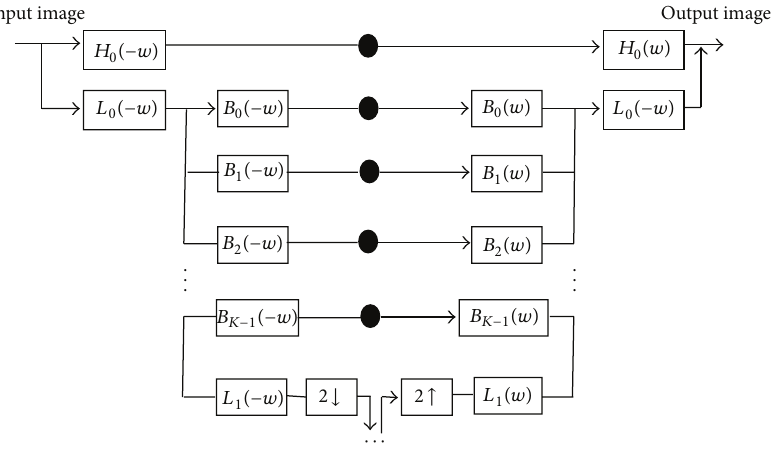
Figure 1: Block diagram of pyramid decomposition